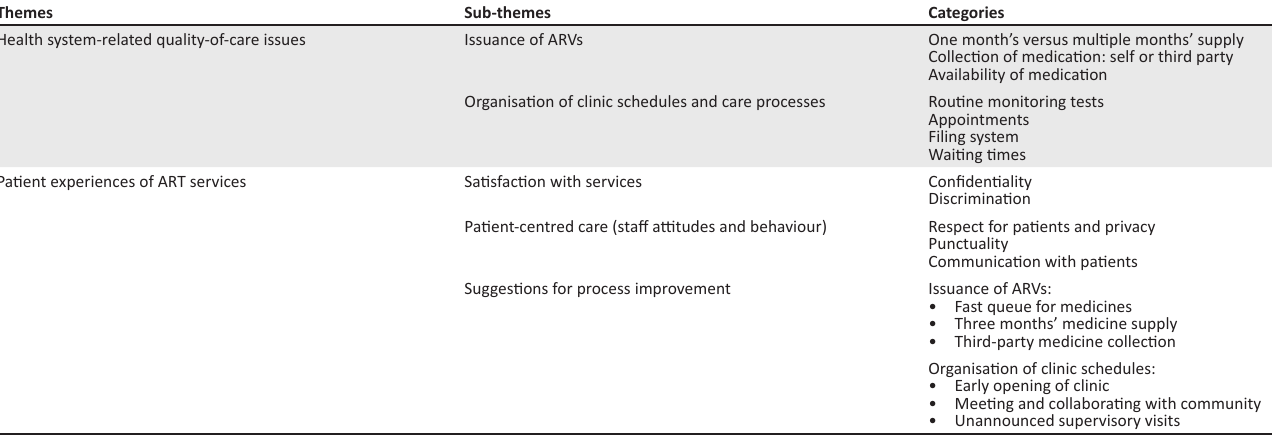
TABLE 2: Patient experiences of antiretroviral treatment services and care.